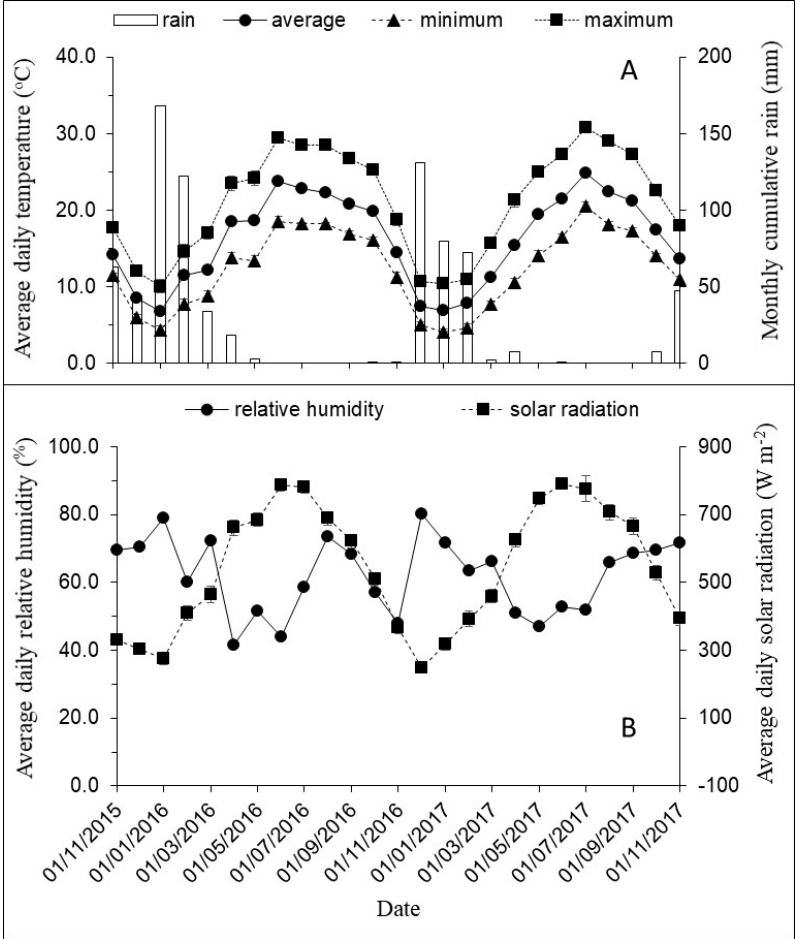
Figure 1. ( A ) Maximum, average and minimum daily air temperatures and monthly cumulative precipitation. ( B ) Average daily relative humidity and solar radiation during the daytime (0800 to 1600 h) based on daily measurements at the experiment site (website of the Israel Meteorology Services, http://www.meteo.co.il/report/SingleStationReport, accessed on 12 January 2021). SE values are based on daily measurements. For most of the dates, the SE values are smaller than the symbols.